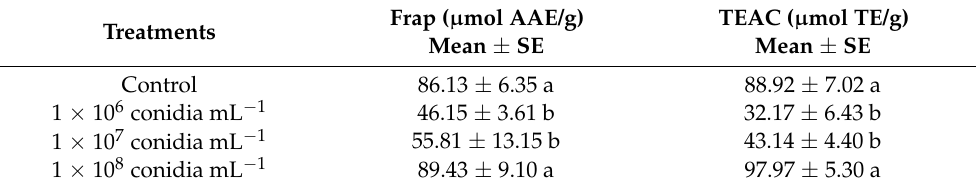
Table 4. The effect of Beauveria bassiana on the antioxidant capacity of lettuce extracts following exposure of plants ( Lactuca sativa ) to different conidial treatments during cultivation ( n = 12).